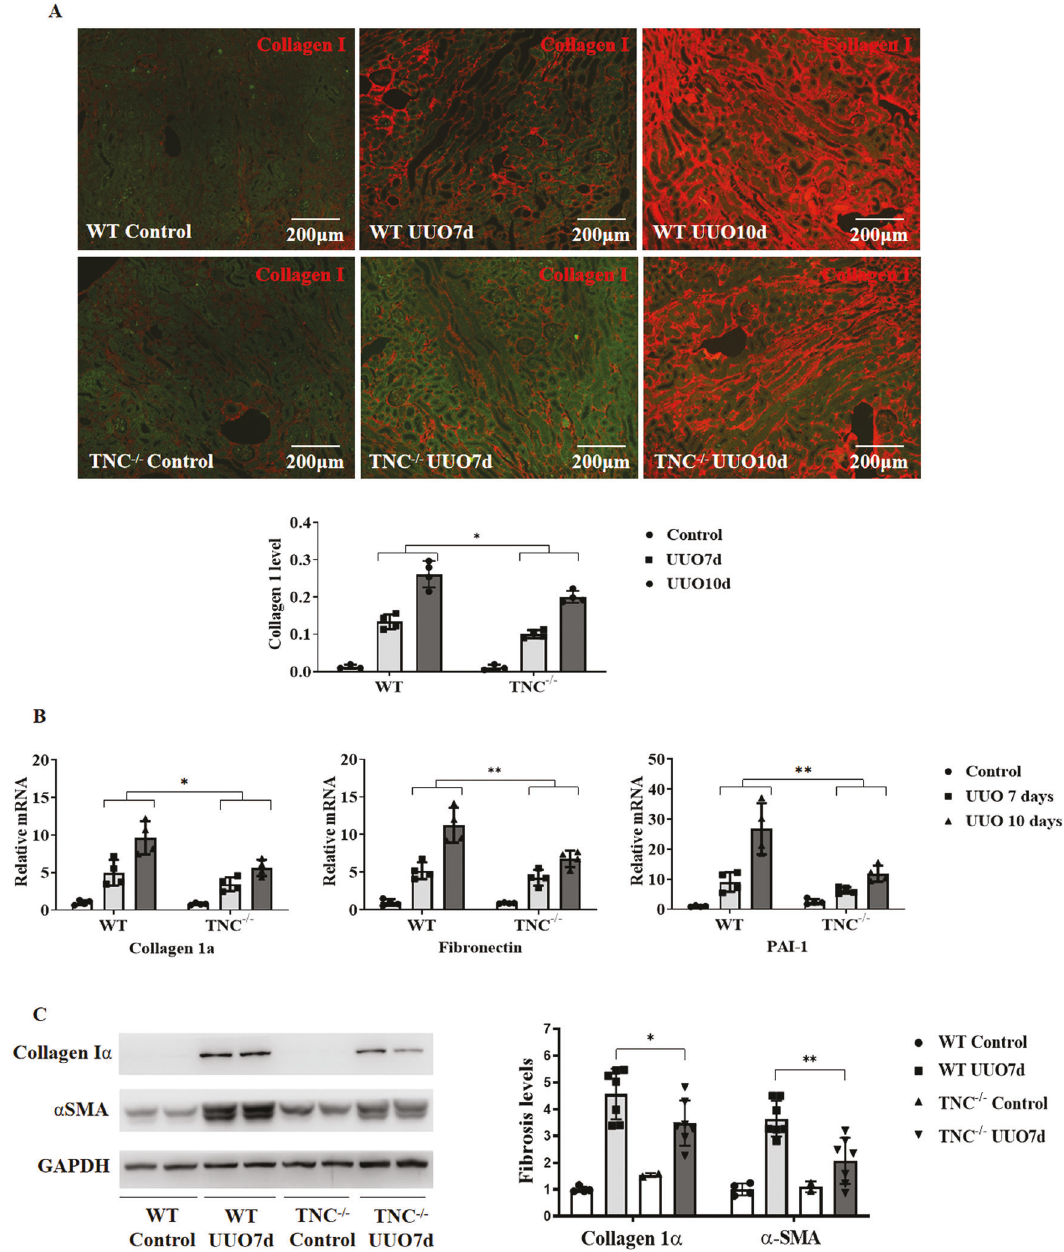
Fig. 3 TNC de fi ciency reduced kidney fi brosis in animal models. Deletion of TNC (TNC − / − ) signi fi cantly attenuated the induction of collagen I assessed by IF following UUO by approximate 30% at day 7 and 10 compared with their wild-type littermates ( A , n = 4 for each time point, two-way ANOVA p < 0.05). Consistently, the expression of fi brosis markers, such as collagen I α , fi bronectin and plasminogen activator inhibitor-1 (PAI-1), were signi fi cantly lower in TNC − / − mice at UUO day 7 and 10 ( B , n = 4 for each time point, two-way ANOVA, p < 0.05). Western blot showed that the proteins of collagen I α and α -SMA were also signi fi cantly reduced in TNC − / − mice at UUO day 7 ( C , n = 7, p <